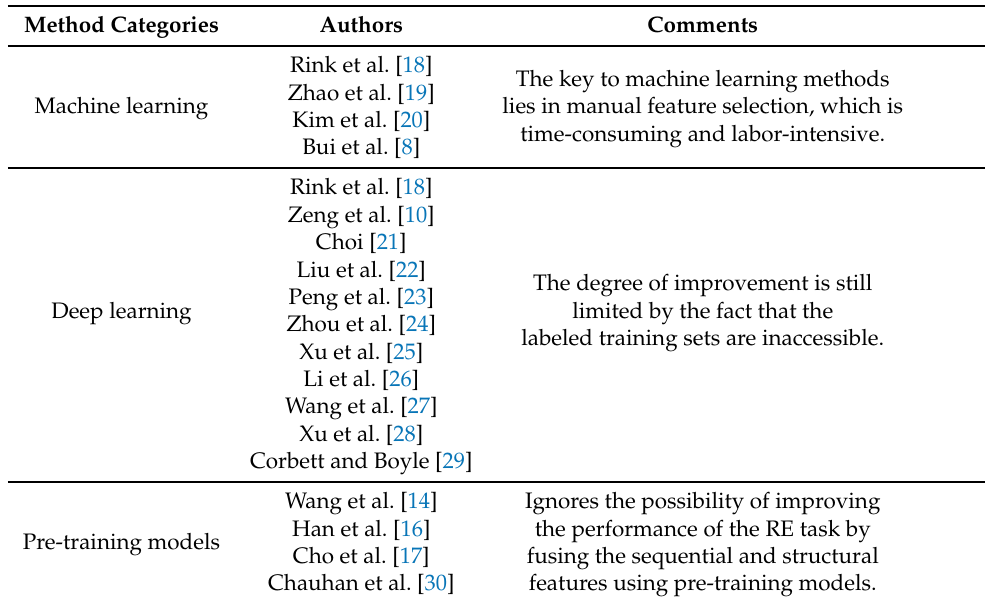
Table 1. Related work in the field of